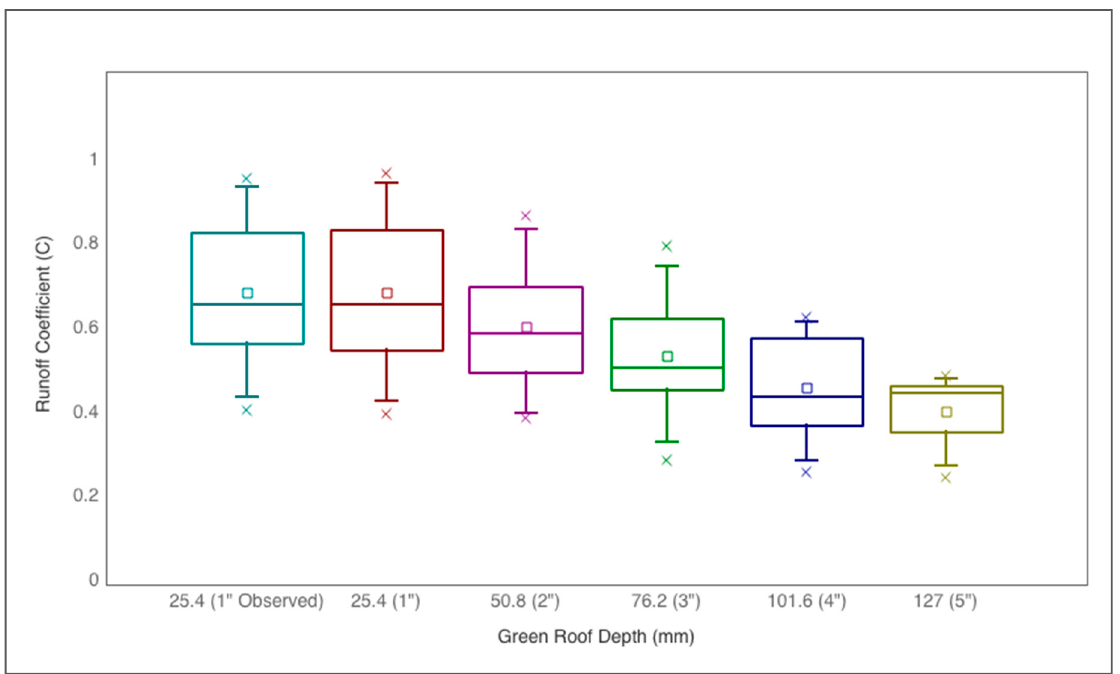
Figure 12. Variation in runoff coefficient ( C ) for varying green roof depths and areas. Boxes represent 25th and 75th percentiles, whiskers represent 5th and 95th percentiles.